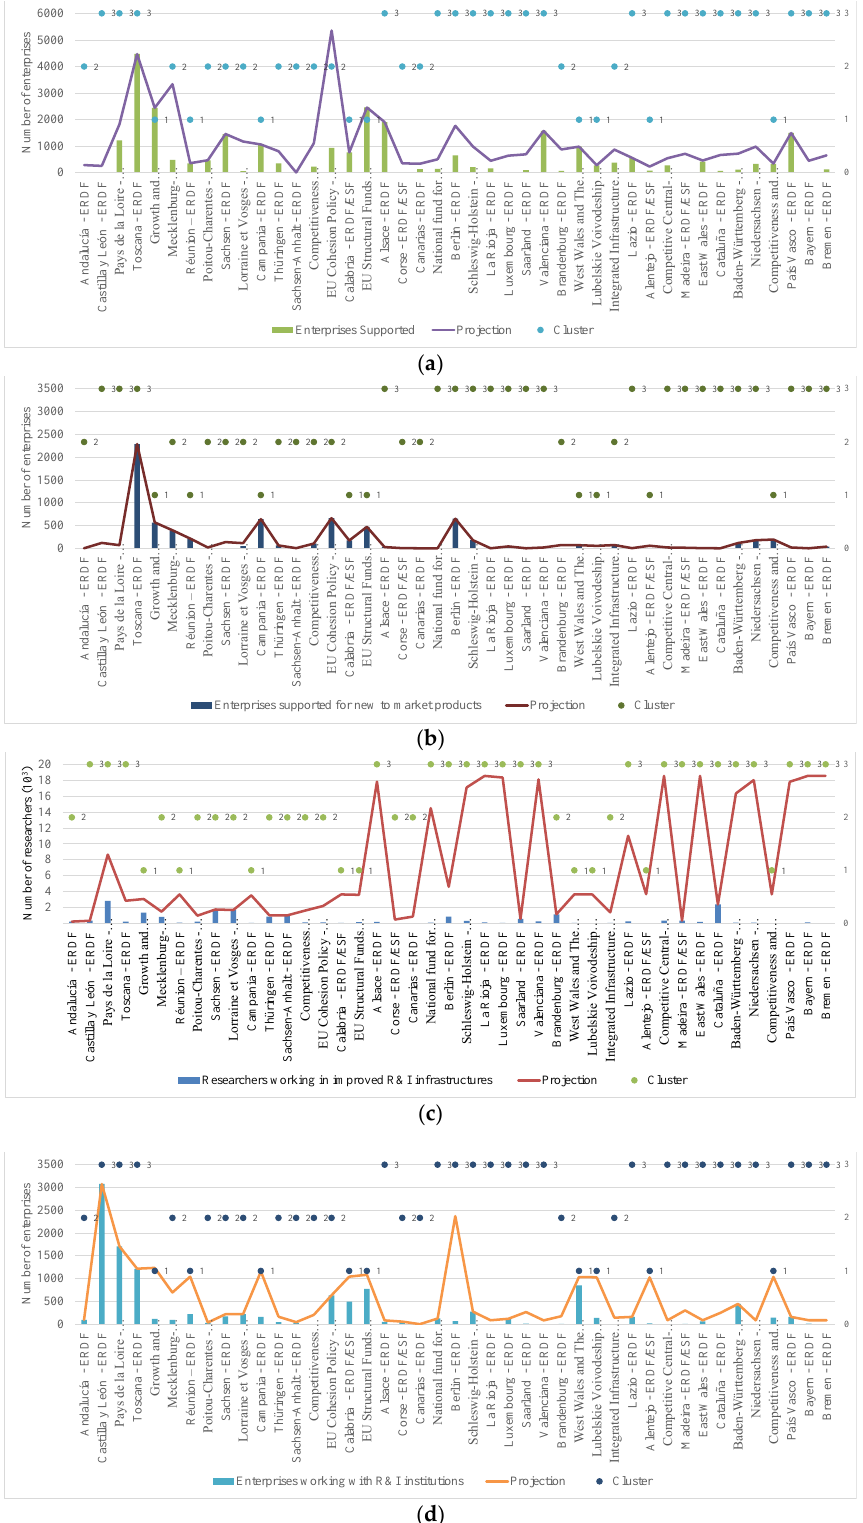
Figure 5. Potential improvement of each external output for procedural efficiency ( a , b ) and R&I efficiency ( c , d ) for every inefficient OP according to the network model and the cluster-frontier. Note: 1 — Less Developed, 2 — Transition, 3 — More developed.